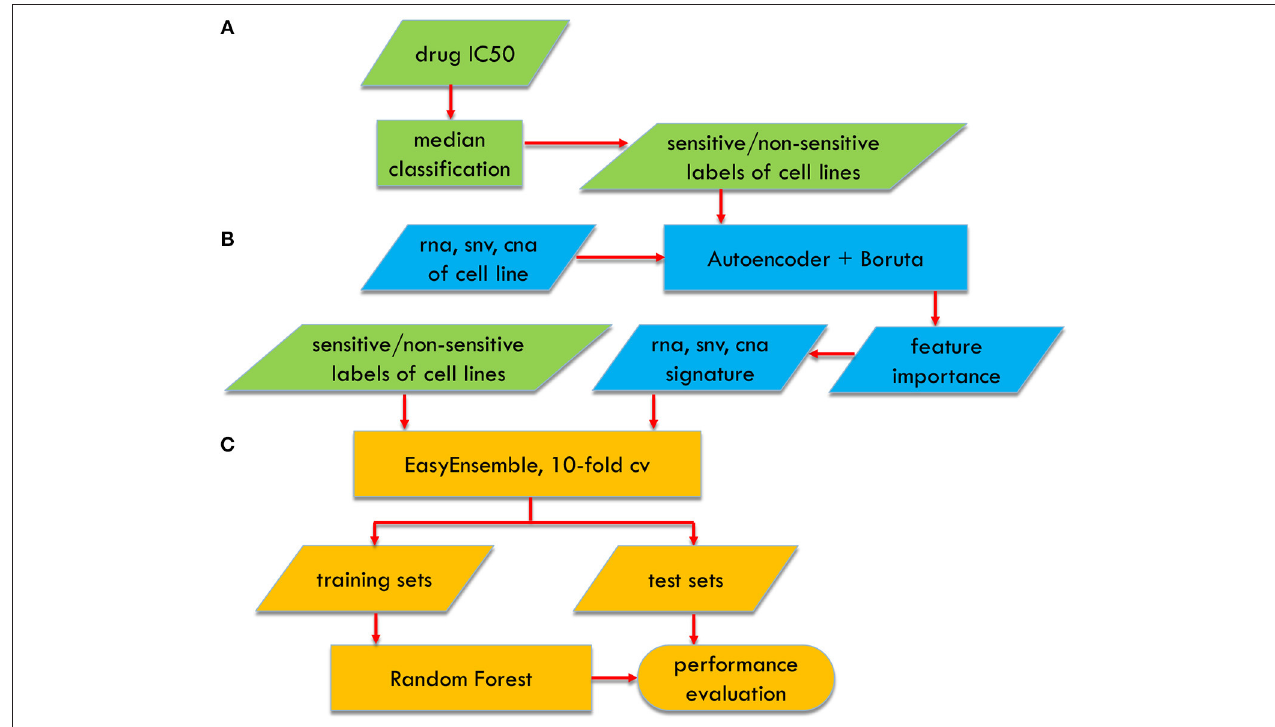
FIGURE 1 | Flowchart of AutoBorutaRF for predicting anticancer drug response, which includes three parts: (A) data preprocessing, (B) feature selection, and (C) classifier constructing.